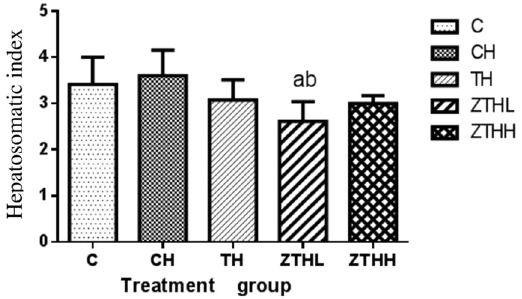
Figure 3. Effect of zinc selenium tea on hepatosomatic index (%, n = 10, mean and SEM) in experimental groups. a Vs C-group, p < 0.05; b vs CH-group, p < 0.05.